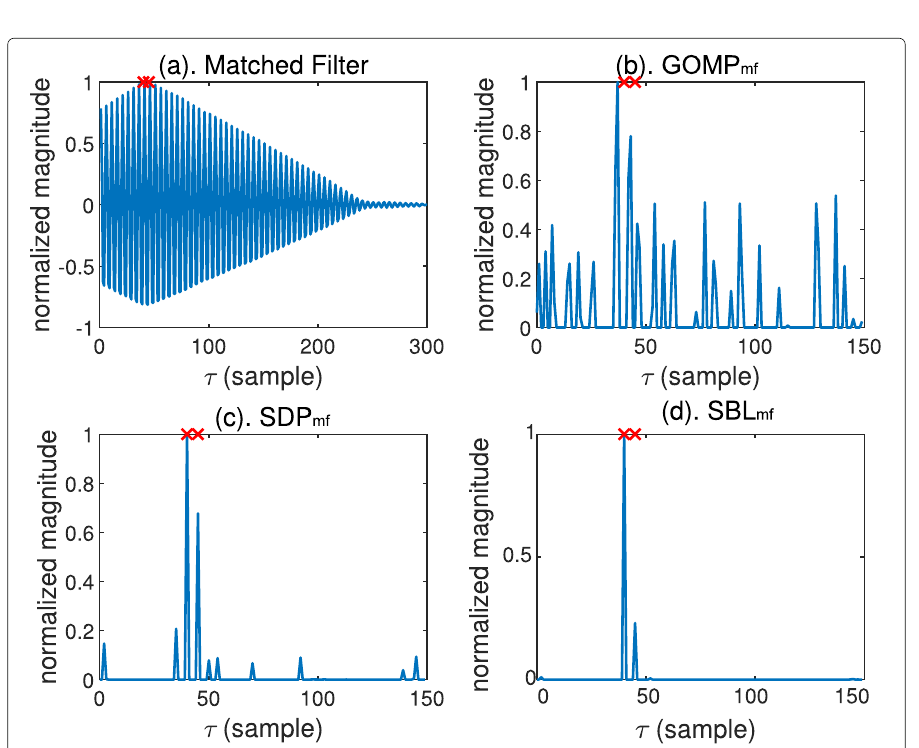
Fig. 2 Time delay estimation in